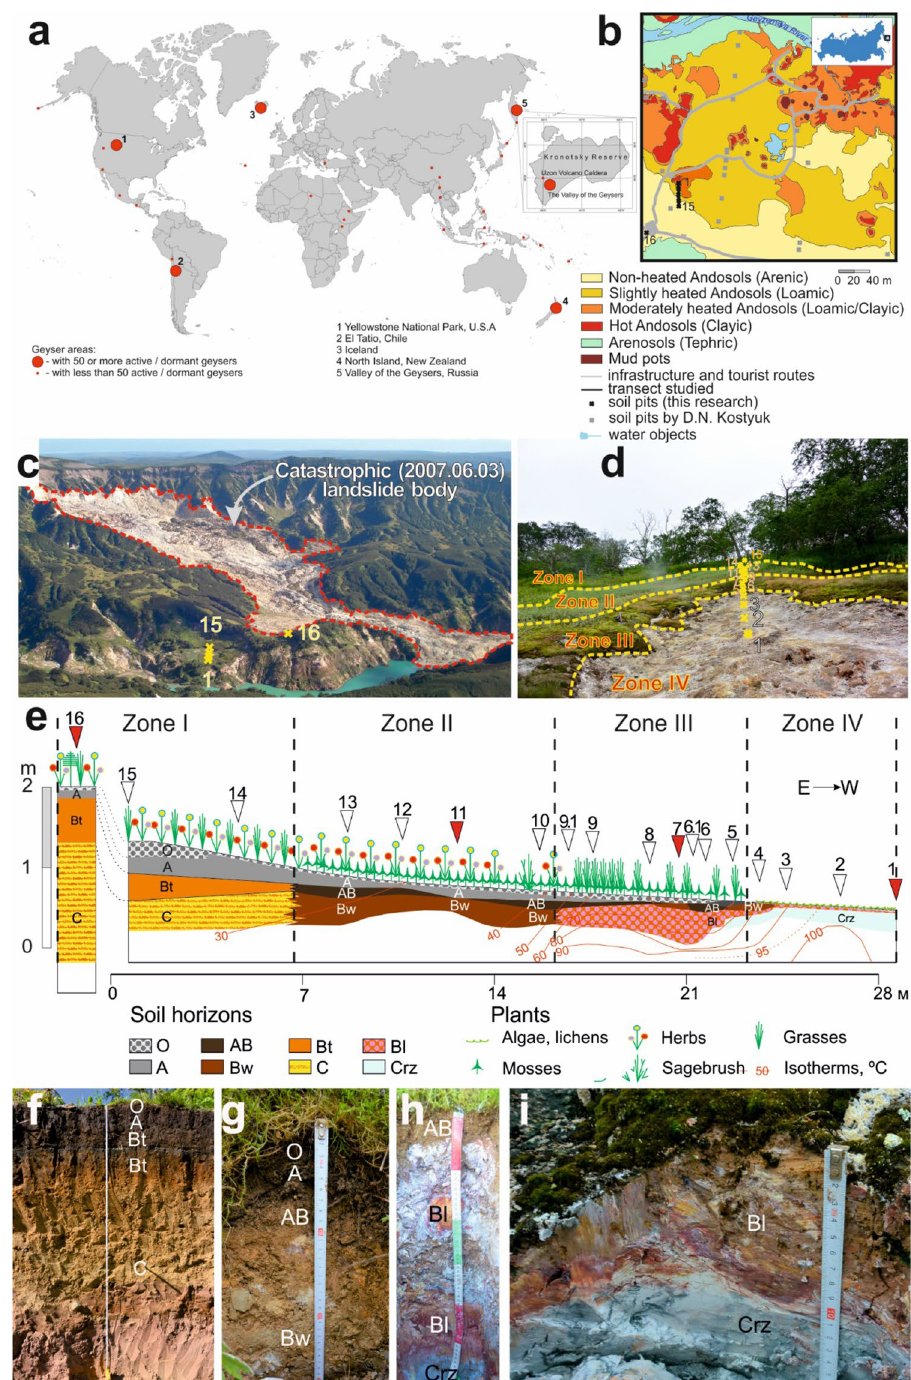
Figure 1. Location of study area ( a – c ), soil pits along the catena ( d , e ) and photos of soil pits ( f – i ). ( a b ) Study area location. Soil map is from 133 (open access) with additions and corrections by I.N. Semenkov based on the map of soil temperature at a depth of 15 cm in the Valley of Geysers 131 and the soil names from 44 using CorelDraw X7 software (https:// www. corel draw. com/). ( c ) Top view of the left side of the Geysernaya River with the body of a catastrophic landslide, a visitor center (in the left lower part) and the location of the transect studied (1–15). ( d ) The location of transect studied. ( e ) A schematic profile of the catena studied with numbered soil pits. The main soil pits selected for comprehensive analyses (see section ‘Soil analyses’) are in red. ( f ) Non-heated Eutrosilic Silandic Andosols (Arenic, Cutanic) on pyroclastic material (pit no 16, Zone I), within levelled parts of the interfluve, under tall-herb meadow communities with local patches of Erman’s birch woods. ( g ) Slightly heated Eutrosilic Aluandic Andosols (Cutanic, Loamic, Natric) in the upper part of the catena, on hydrothermally altered sandy-loamy pyroclastic material (pit no 12, Zone II), on slightly heated slopes, under tall-herb meadows. ( h ) Moderately heated Eutrosilic Gleyic Aluandic Andosols (Loamic, Reductic, Protosalic, Hyperthionic) in the middle part of the catena, on hydrothermally altered clayey pyroclastic material (pit no 9.1, Zone III), under different moss and ‘microzonal’ communities. ( i ) Hot Gleyic Aluandic Andosols (Clayic, Reductic, Salic, Hyperthionic) in the lower part of the catena, on hydrothermal clays (pit no 4, Zone IV), on most heated bare